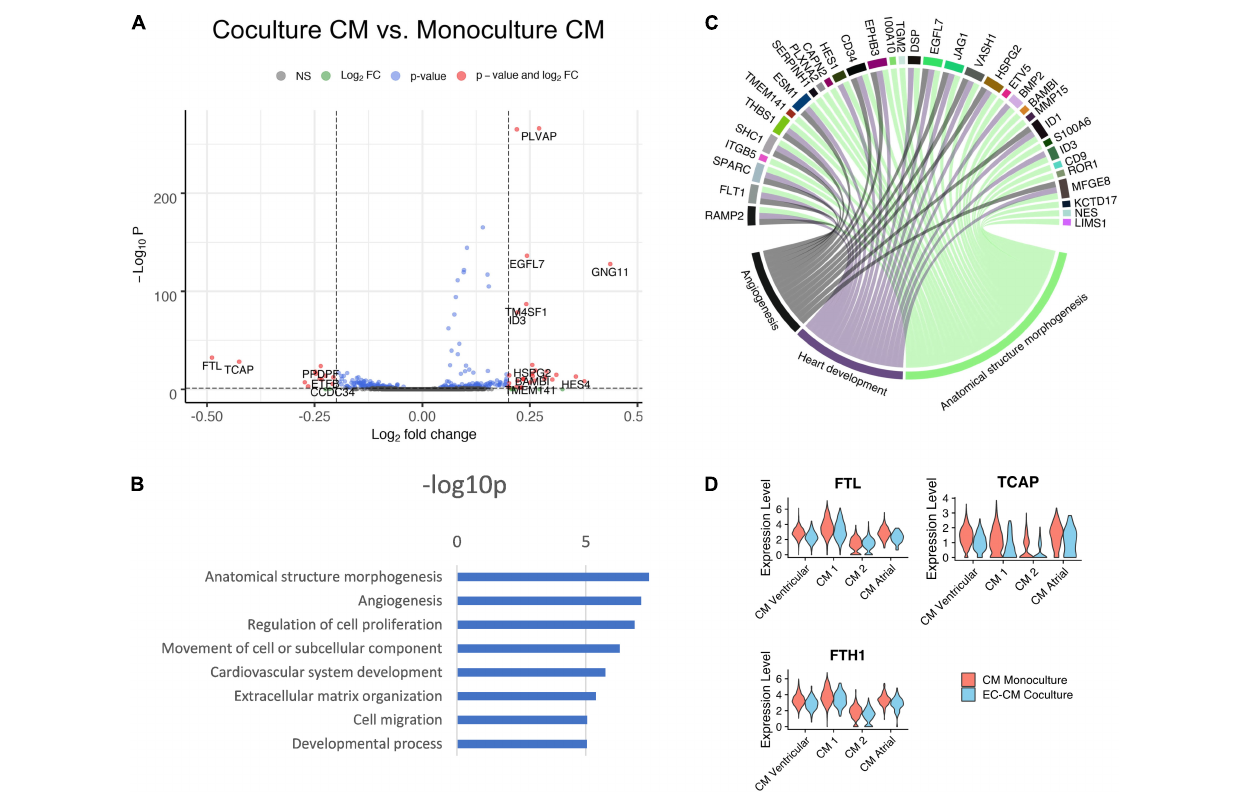
FIGURE 6 | Comparison of co-culture and monoculture hiPS-CMs. (A) Volcano plot of altered genes in co-culture hiPS-CMs compared to monoculture hiPS-CMs. (B) GO-analysis on differentially expressed genes that are upregulated (fold change > 0.10) in co-culture hiPS-CMs–eight representative categories are presented. (C) Upregulated genes in three relevant GO categories. (D) The sarcomeric gene TCAP , and FTH1 and FTL that build the cytoplasmic iron storage protein ferritin, were all significantly downregulated in co-culture hiPS-CMs. All scRNAseq data presented in the figure consists of combined data from HEL47.2 and HEL24.3